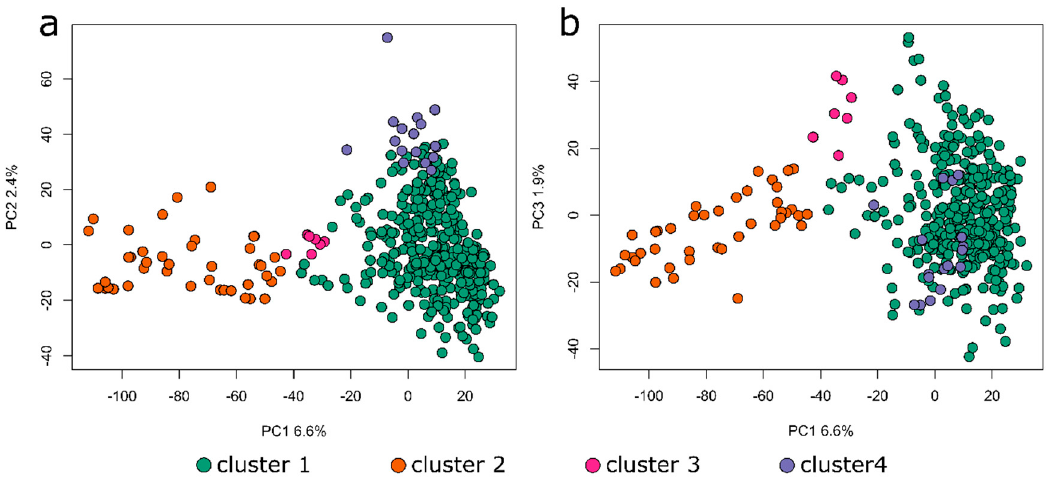
Figure 5. Principal component analysis of the population structure as determined from the 1 marker for every 50,000-base, dataset X-Y ( a ) and X-Z ( b ). The marker colors correspond to the populations shown in Figure 4.